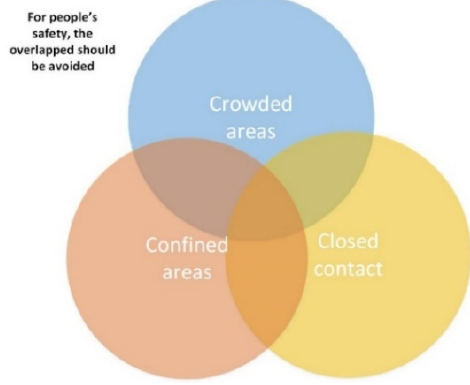
Figure 1. COVID safety precaution.